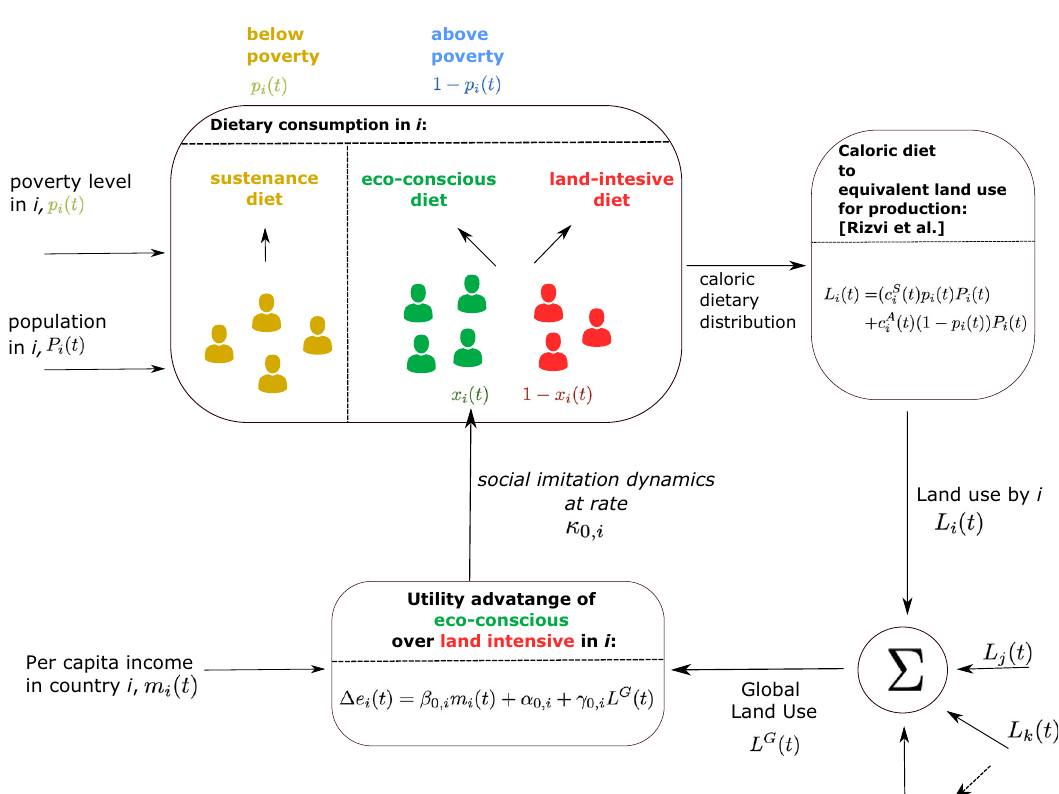
Fig. 1 A graphical representation of the coupled two-way feedback model between global land use and dietary behavior in populations. We consider country-level populations. Each country has two subpopulations — the subpopulation below the poverty level and the subpopulation above the poverty level. The subpopulation below the poverty level in i (which occupies a fraction of p i ( t ) of the total population in i at time t ) consumes a sustenance diet that requires a number of c S i ð t Þ hectares individual − 1 land, globally, to be produced at time t (measured in years). The subpopulation above the poverty level in i can choose between an eco-conscious diet or a land-intensive diet (details can be found in Methods). It requires an amount of c A i ð t Þ hectares individual − 1 land at time t , globally, to produce the average dietary consumption of the population above-poverty in i . The method for calculating c A i ð t Þ can be found in Eq. (5). The method for converting a caloric diet to equivalent amount of land required to produce the diet can be found in Methods. Global land use at t , per-capita income in country i at t , m i ( t ), and social parameters in i — β 0, i , α 0, i , γ 0, i , determine the utility advantage of an eco-conscious diet over a land- intensive diet in i . The utility advantage Δ e i ( t ) along with the social learning rate, κ 0, i , drive the social imitation dynamics that determines the rate of change of x i ( t ), the proportion of above-poverty sub-population in i consuming an eco-conscious